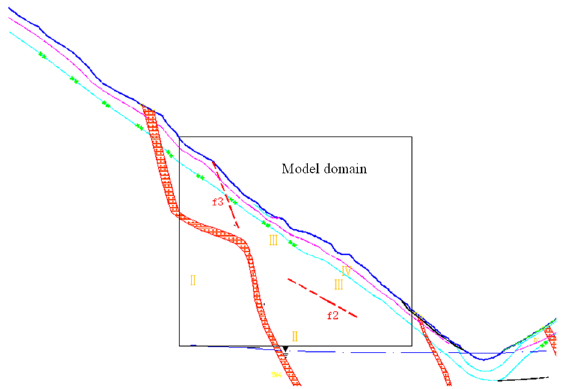
Figure 1. Geological map of the left bank slope.